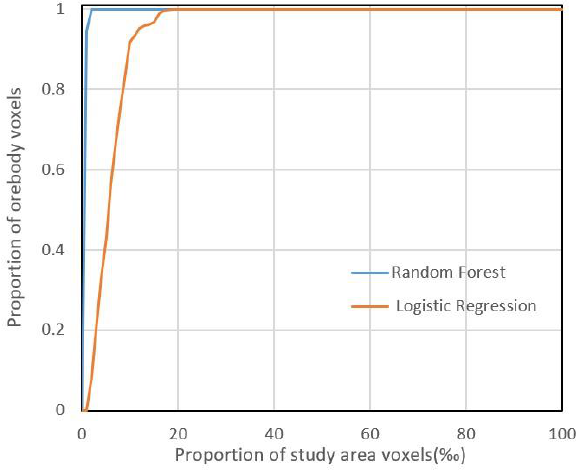
Figure 10. Capture efficiency curves.